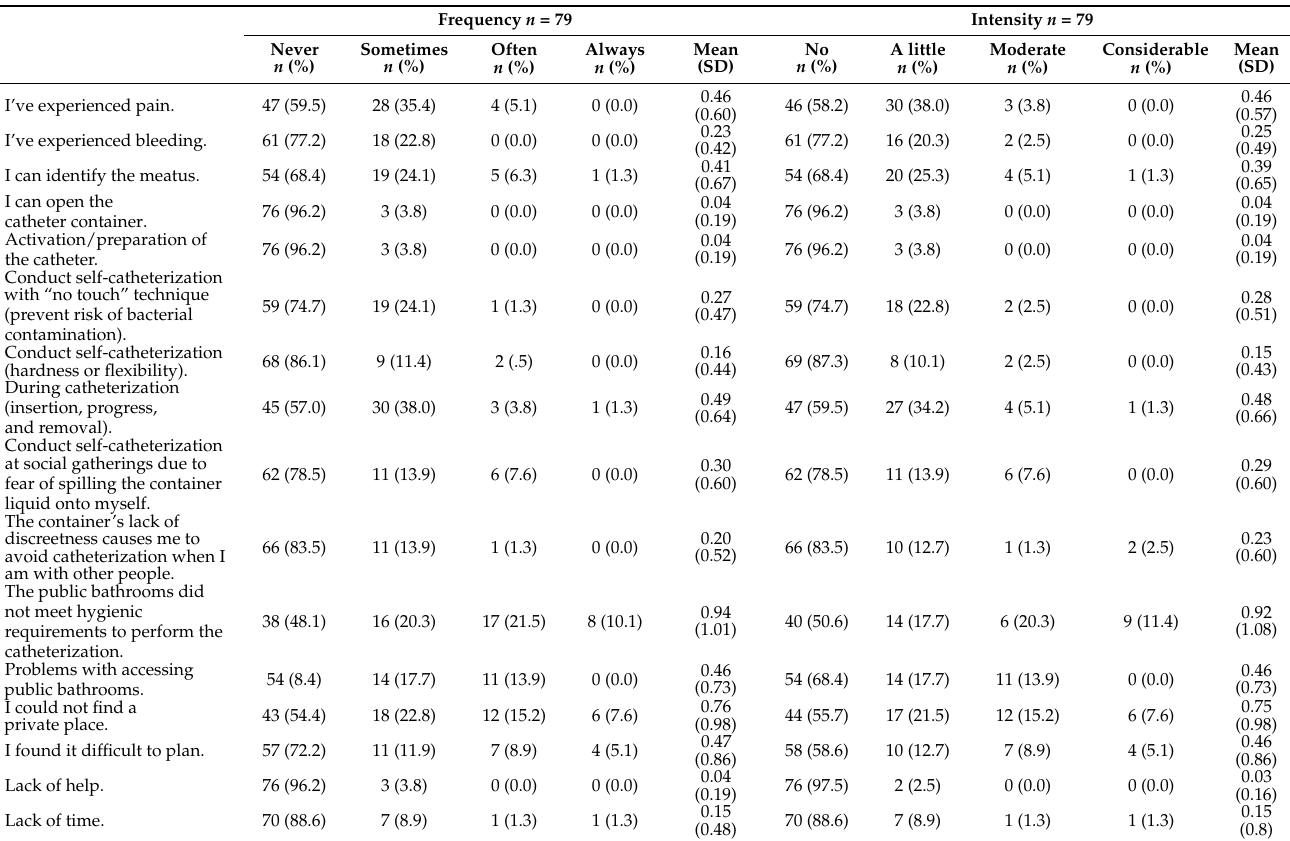
Table 7. Difficulty performing bladder catheterization.